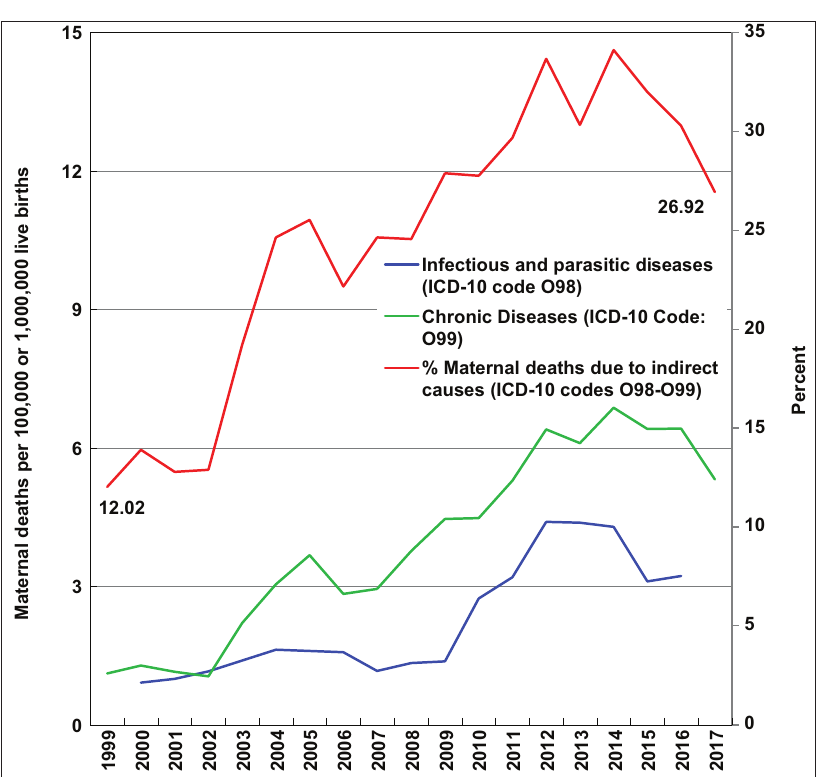
Figure 2: Trends in maternal mortality from infections (ICD-10 code O98) and chronic diseases (ICD-10 code O99), and proportion of all maternal deaths due to indirect obstetric causes (ICD-10 codes: O98-O99), United States, 1999-2017 Source: Data derived from the National Vital Statistics System Rates of maternal mortality from infections are three-year moving average rates and are per 1,000,000 (million) live births. Rates of maternal mortality from chronic diseases are annual rates and are per 100,000 live